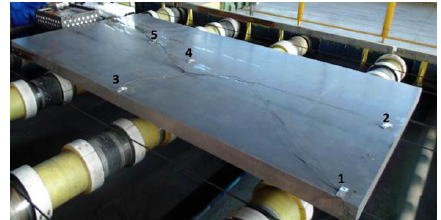
Figure 12. Detail with the position of thermocou-